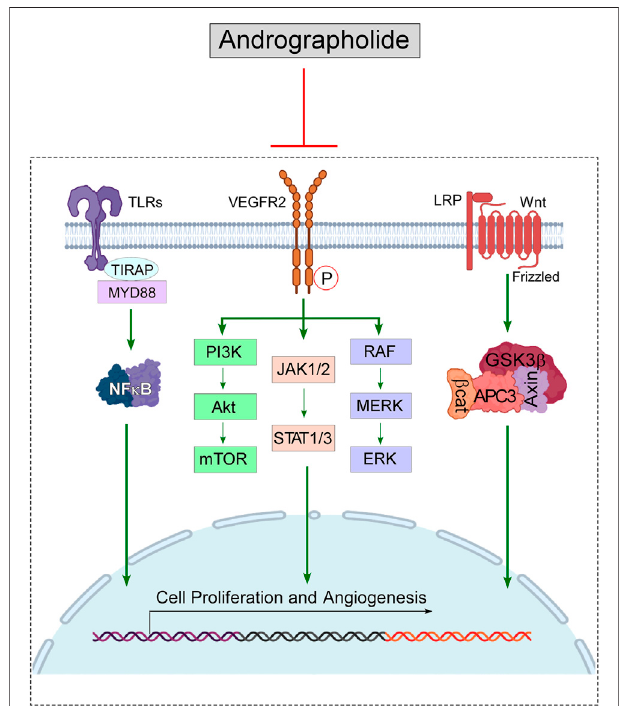
FIGURE 4 | Diagram representing the immunomodulatory role of Andrographolide on the signaling pathways, that cause cancer: Andrographolide inhibits the functioning of NF κ B, thus hampers the downstreamsignalingpathwaymediated via MMP9;blockstheVEGFR- mediated PI3K/Akt, ERK & JAK/STAT signaling, which stimulate tumor progression;down-regulates β -catenine( β -cat)andsuppressesWntsignaling pathway to block tumor progression. Blocking of these signaling pathways lead to the suppression of cell proliferation and angiogenesis process, which eventually can cause tumor